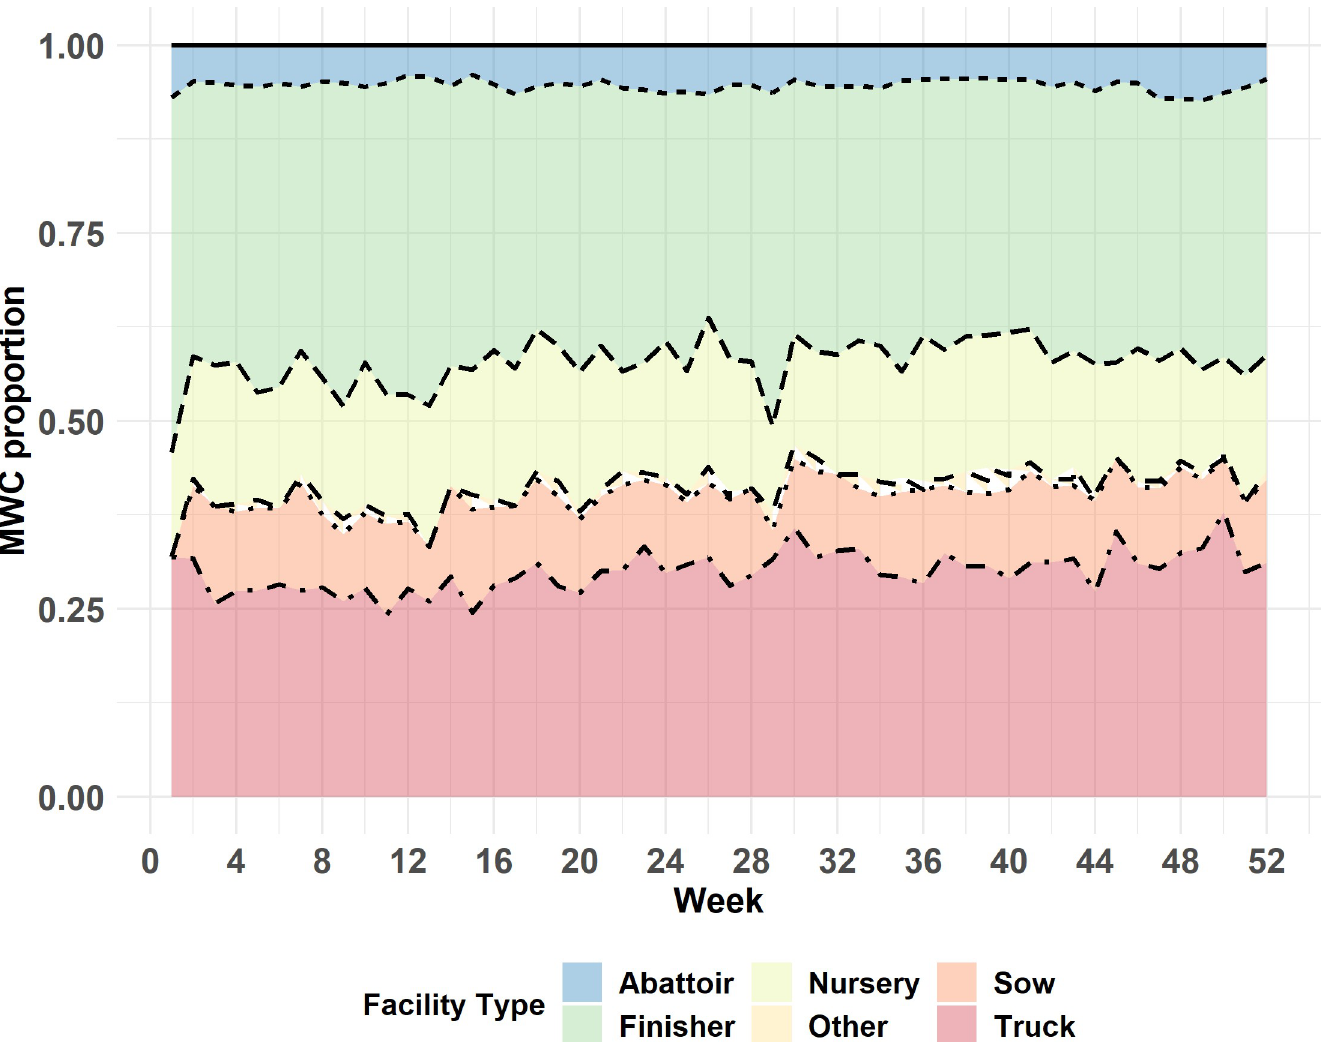
Fig 1. Proportional representation of each facility type within weekly maximum weak components for the year of 2015, calculated on the basis of two-mode network. The total number of nodes in a specific week in the MWC has been used as a denominator.